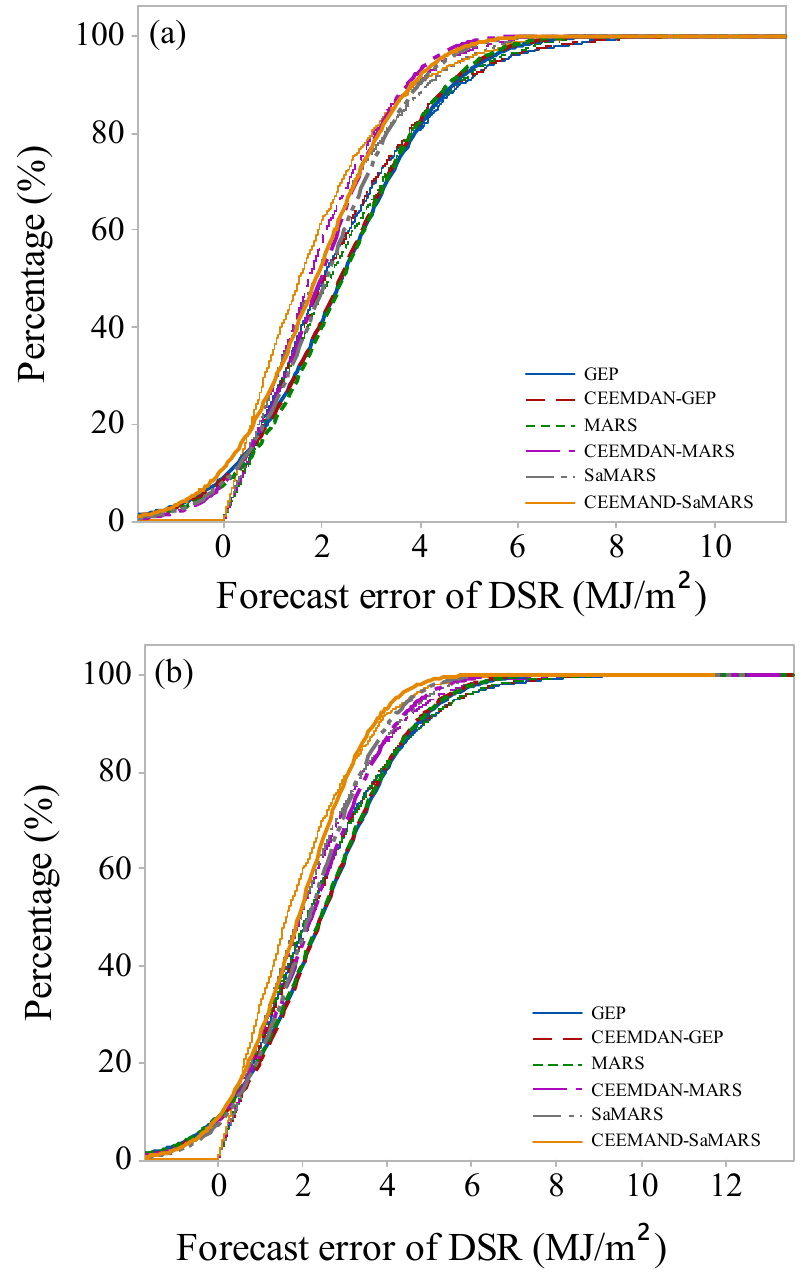
Figure 11. Empirical cumulative distribution function of the absolute forecasted error (MJ/m 2 ) using the standalone and hybrid models at ( a ) Busan ( b ) Incheon stations in the validation phase.